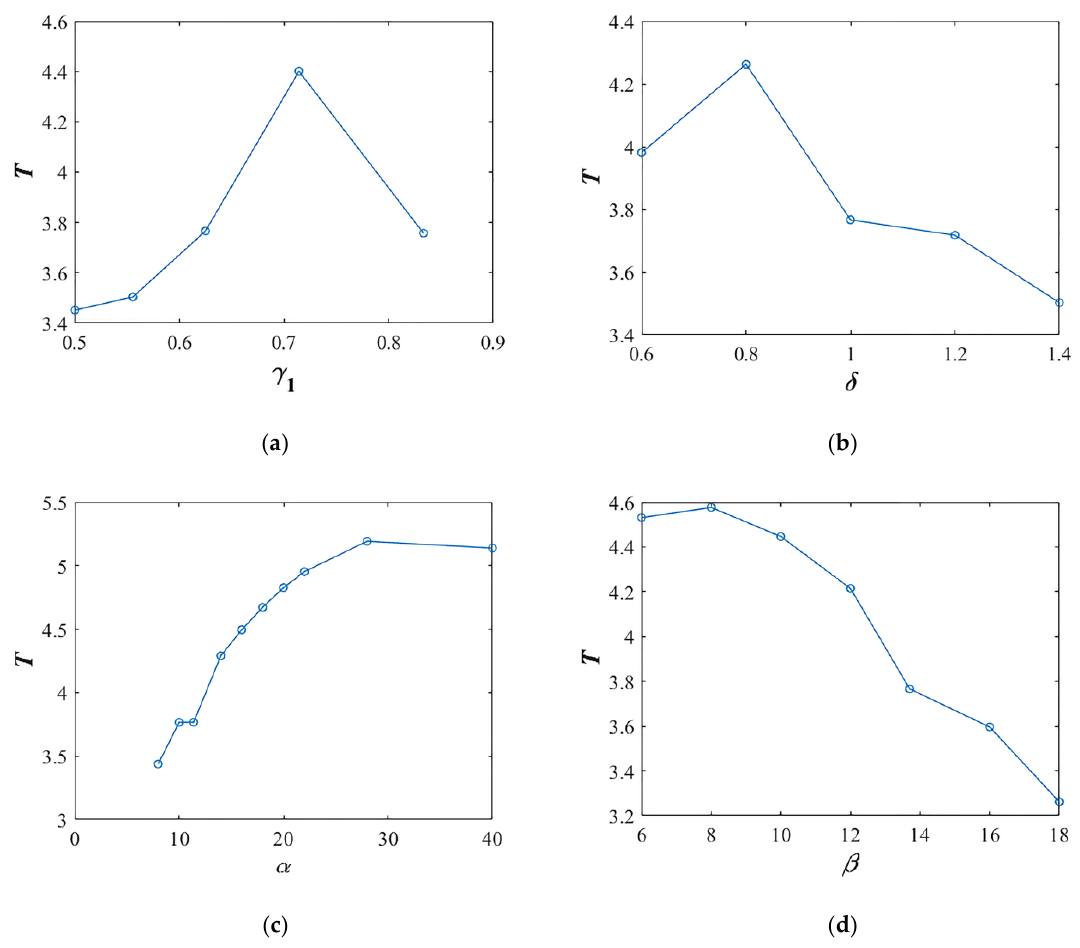
Figure 9. The effects of ( a ) γ 1, ( b ) δ, ( c ) α and ( d ) β on the VT performance T.